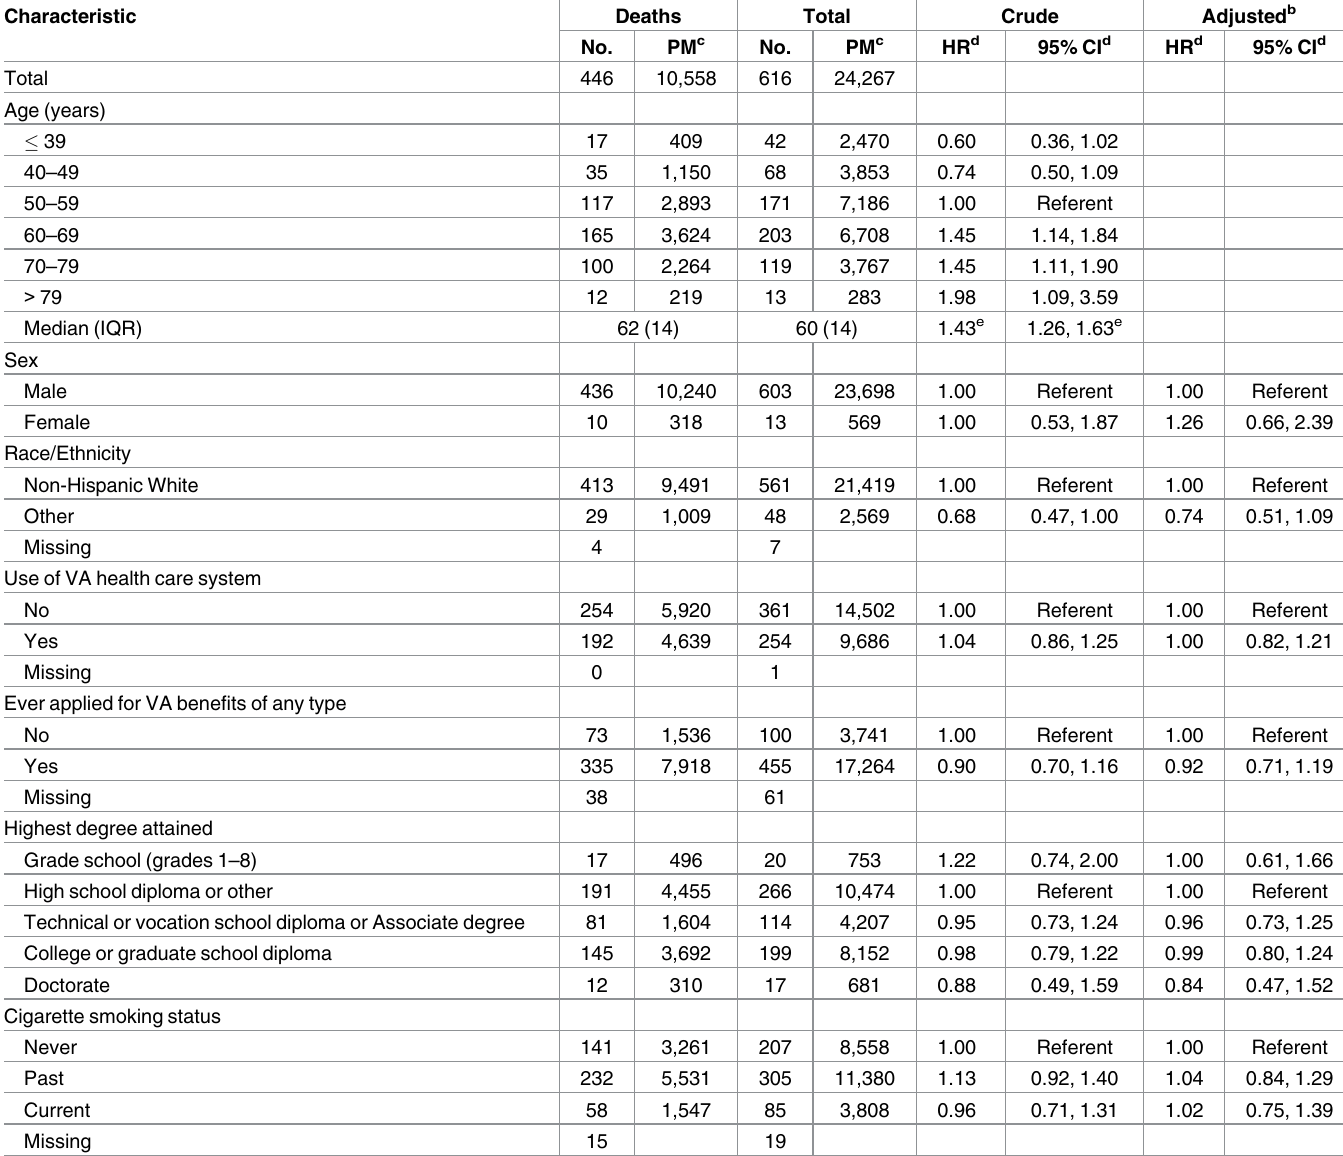
Table 1. Demographic characteristics of amyotrophic lateral sclerosis deaths and total cases a in GENEVA, United States of America, 2005–2013.